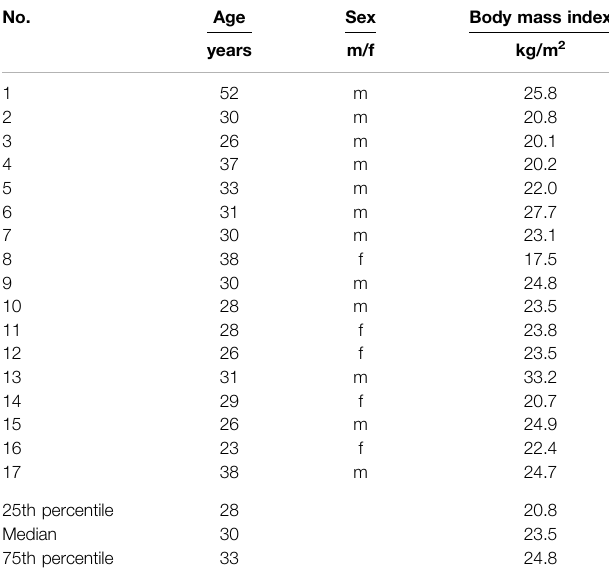
TABLE 1 | Characteristics of the volunteers examined in our